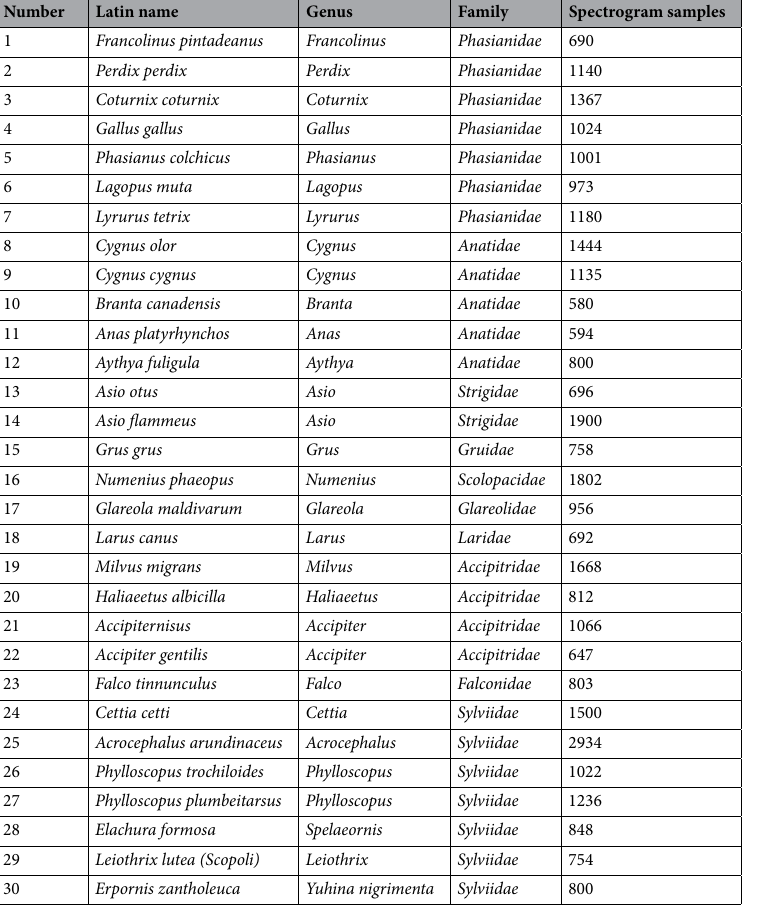
Table 1. Description of